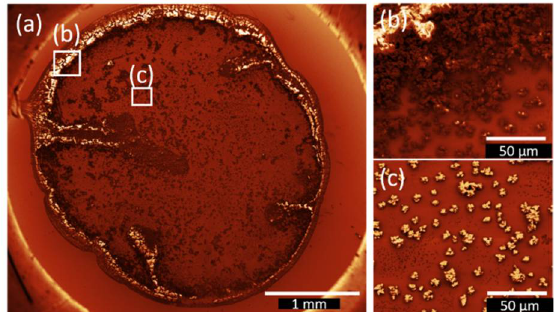
Figure 4. SEM image of 2 –DrE film after the evaporation of the solvent. The images were treated with the Gwyddion.net image filter from Gwyddion software: ( a ) the film shows characteristic features of the coffee stain effect in combination with Ostwald ripening, ( b ) indicates rough film edges and large agglomerations of bismuth oxido clusters at the drop edge, and ( c ) displays the middle part of the film with agglomerations of different size next to each other and the trend to more pronounced depletion zones around the larger agglomerations, which is an indicator for Ostwald ripening.